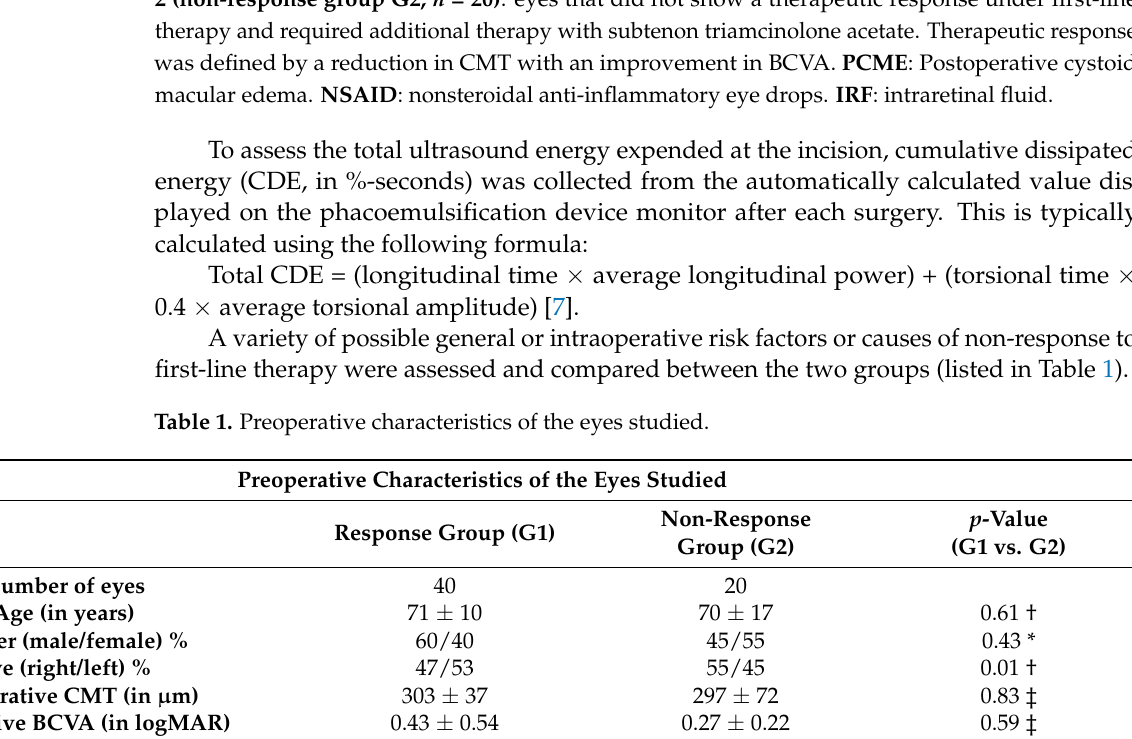
Table 1. Preoperative characteristics of the eyes studied.